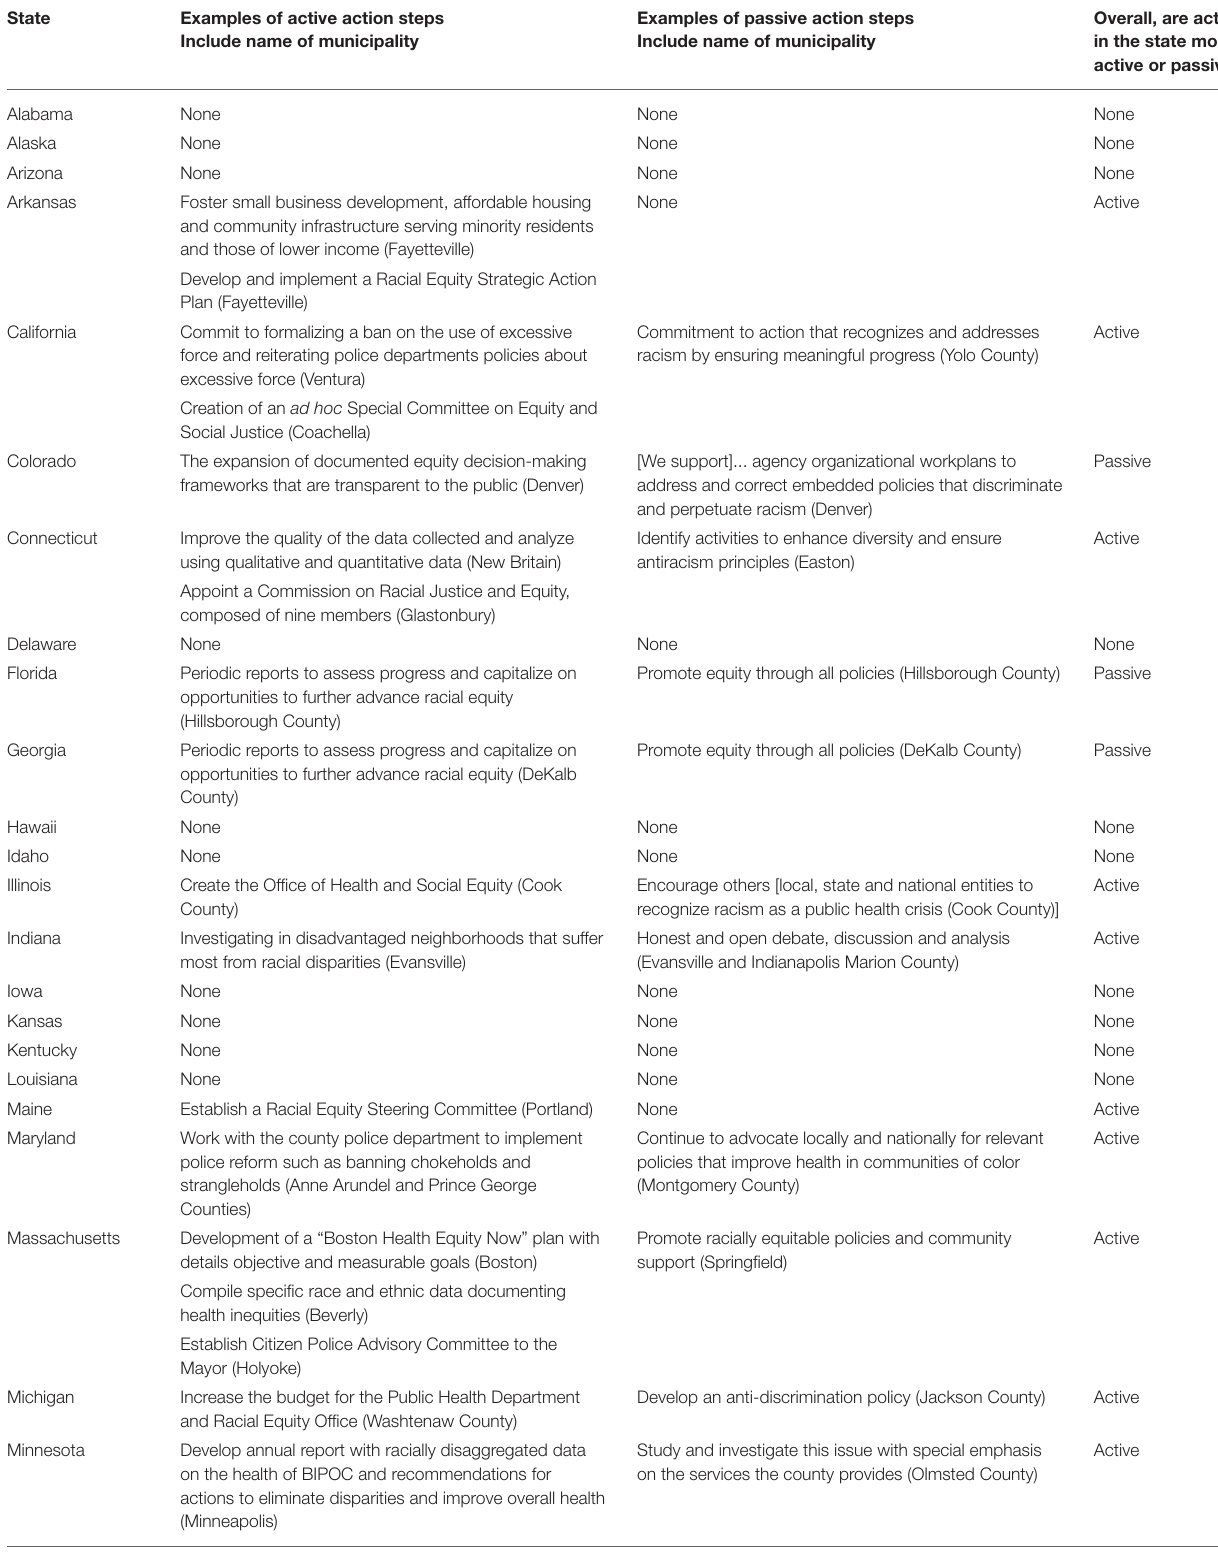
TABLE 2 | Summary of legislation implemented active and passive action steps related to racism as public health crisis.